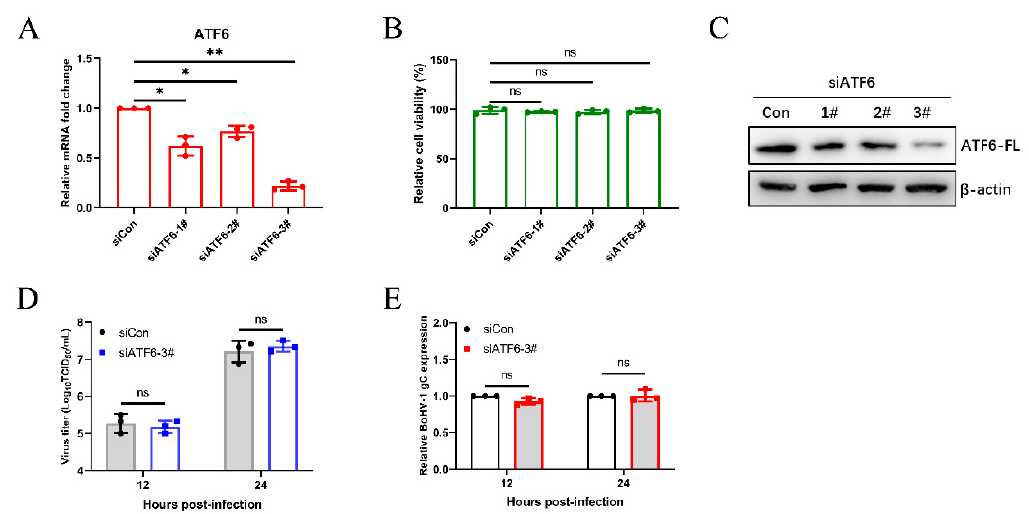
Figure 3. The virus-induced ATF6 pathway does not affect BoHV1 replication. MDBK cells were transfected with siRNA targeting ATF6 or scrambled siRNA (siCon). ( A ) The silencing efficiency of ATF6 was measured by qPCR in MDBK cells at 24 h post-transfection. ( B ) The CCK-8 assays were used to analyze the viability of MDBK cells 24 h after transfection. ( C ) Immunoblot analysis of the silencing efficiency of ATF6 at 48 h post-transfection. ( D , E ) At 48 h siATF6-3# post-transfection, MDBK cells were infected with BoHV-1 (0.1 MOI) and harvested at the indicated time points for virus titration and the qPCR analyses. The mean ± SD of data from three independent experiments are shown; * p < 0.05, ** p < 0.01.